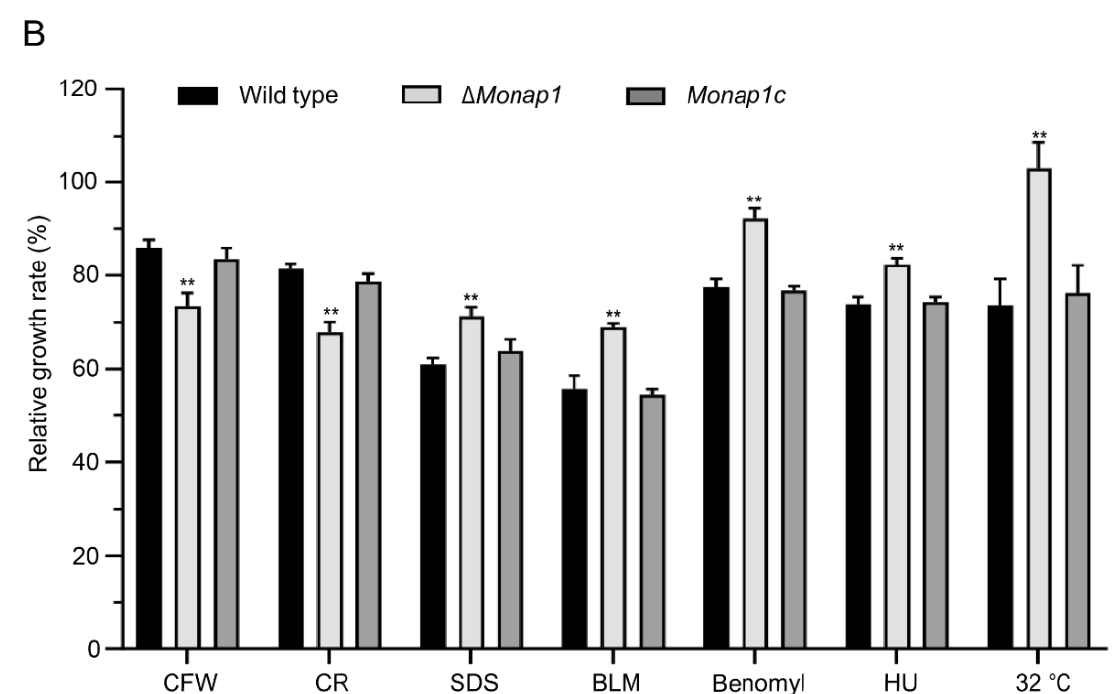
Figure 6. MoNAP1 is involved in the cell wall integrity (CWI) pathway and microtubule dynamics. ( A ) Mycelial colonies of the wild type, ∆ Monap1 and Monap1c strains cultured in CM containing 75 μ g mL − 1 CFW, 600 μ g mL − 1 CR, 0.004% SDS, 35 μ g mL − 1 BLM, 15 μ g mL − 1 benomyl, and 2 mM HU